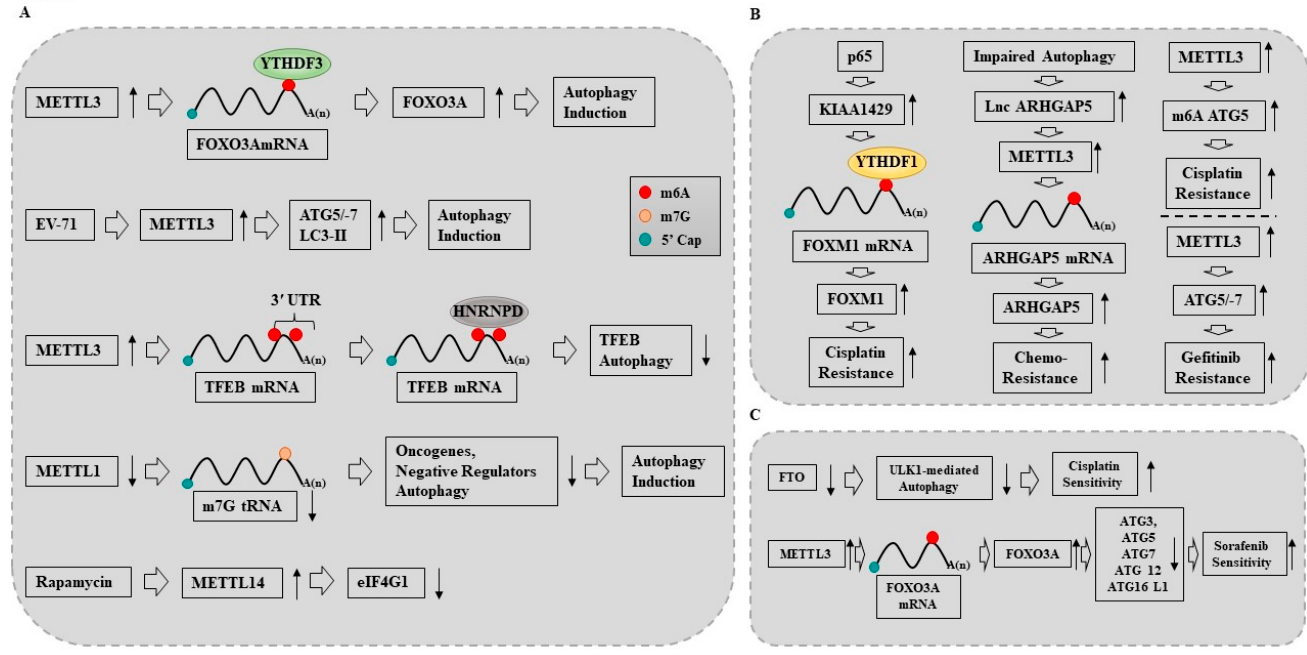
Figure 3. Roles of RNA methyl transferases in autophagy and anticancer drug resistance. ( A ) METTL3 promotes autophagy by increasing the expression of FOXO3A. METTL3 promotes autophagy by increasing the expression of ATG5/-7 and LC3-II. METTL3 inhibits autophagy by decreasing the expression of TFEB. METTL14 mediates the effect of rapamycin, an inducer of autophagy, by decreasing the expression of eIF4G1. Downregulation of METTL1 induces autophagy by decreasing m7G tRNA and oncogenes and negative regulators of autophagy. ( B ) METTL3 promotes or inhibits autophagy in a context dependent manner. ( C ) FTO enhances cisplatin sensitivity by promoting ULK1-mediated autophagy. METTL3 enhances anticancer drug resistance by promoting autophagy. KIAA1429 recruits YTHDF1 to increase the expression of FOXM1, which results in cisplatin resistance. ↓ denotes decreased expression/activity. ↑ denotes positive regulation. Hollow arrows denote direction of reaction. Hollow arrows denote direction of reaction.